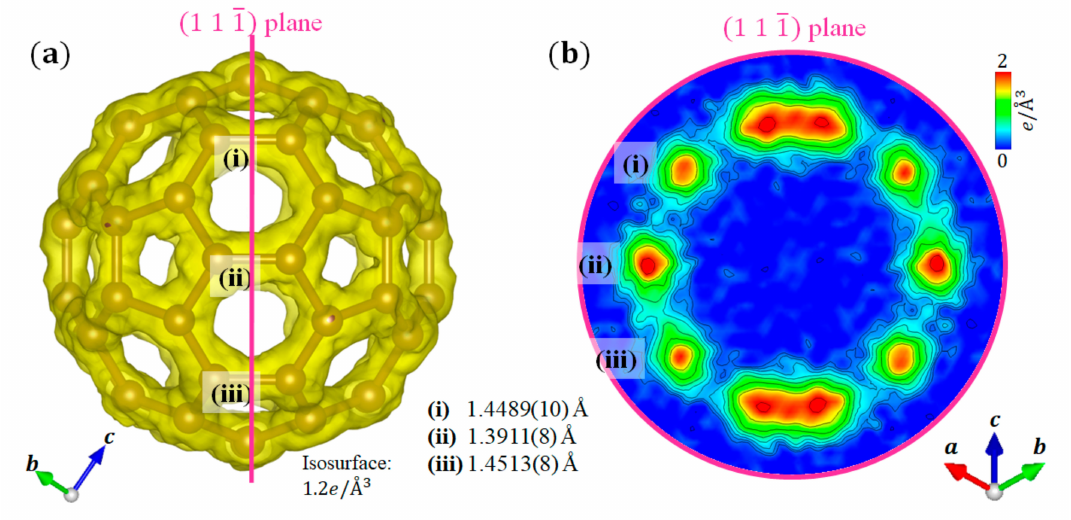
(cid:16) (cid:17) 1 1 1 plane.